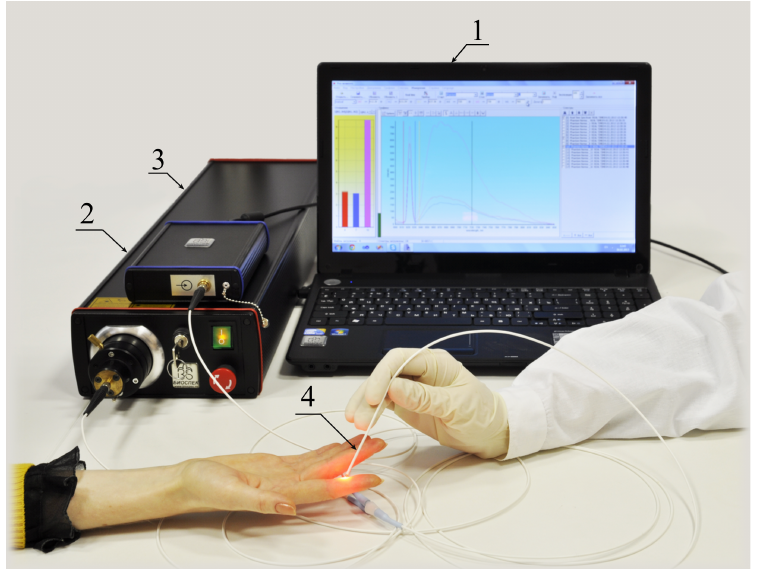
Figure 4. Scheme of a system for measuring fluorescence spectra in vivo : (1) PC with installed software; (2) spectrometer; (3) laser light source; (4) Y-shaped fiber-optic